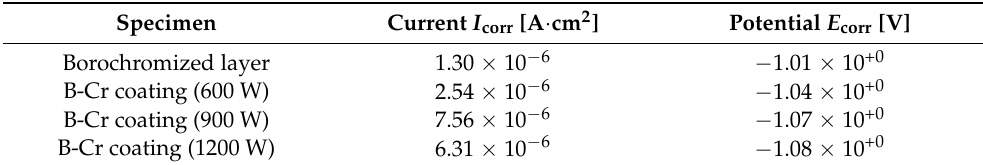
Figure 8. Corrosion resistance of diffusion borochromized layer and B-Cr coatings. Table 3. Corrosion current and corrosion potential for diffusion borochromized layer and B-Cr